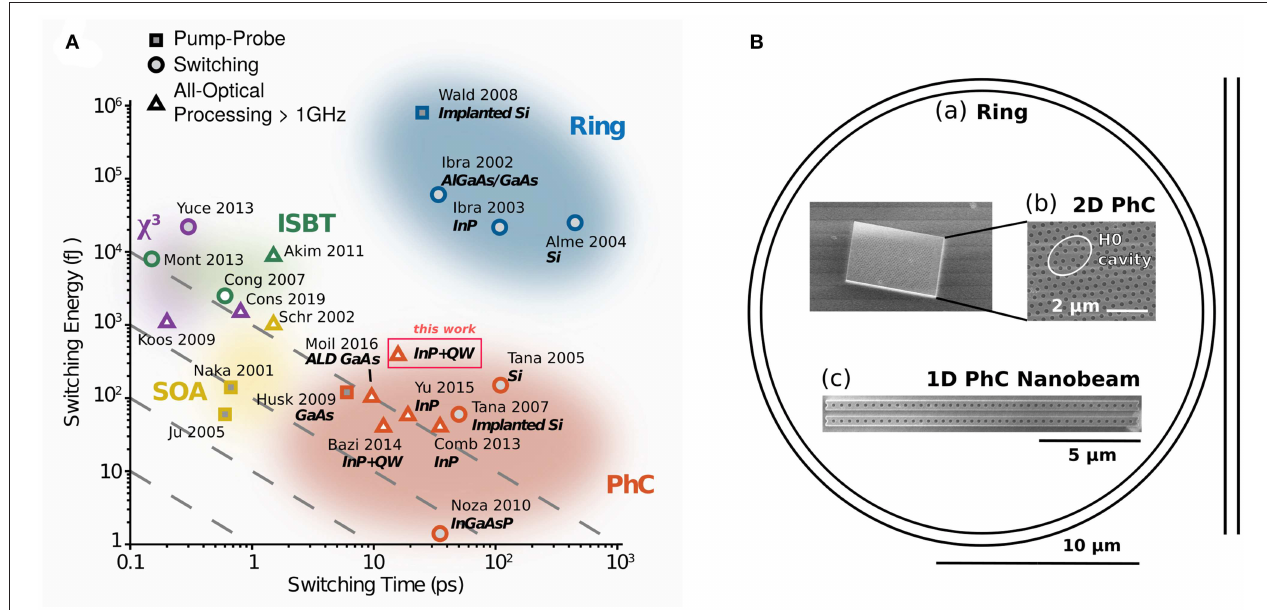
FIGURE 2 | (A) Comparison of different AOGs with respect to the figure of merit switching energy vs. switching time. ISBT, intra-subband transitions. SOAs, semiconductor optical amplifiers. Note that here the energies reported for the SOAs do not include the driving power. PhC, photonic crystal. Keys for references are defined in Table 1 . (B) Examples of different kinds of resonators, enabling to compare the difference in volume, especially between ring resonators and PhC cavities: (a) Schematic of a typical Ring resonator, here with a radius of about 10 microns, as in [35]. (b) 2D PhC cavity called H 0 made of InP: this type of cavity features one of the smallest mode volume, near the diffraction volume [ 14]. (c) 1D PhC cavity called nanobeam made of InP. All pictures have the same scale, except the one showing the whole 2D PhC